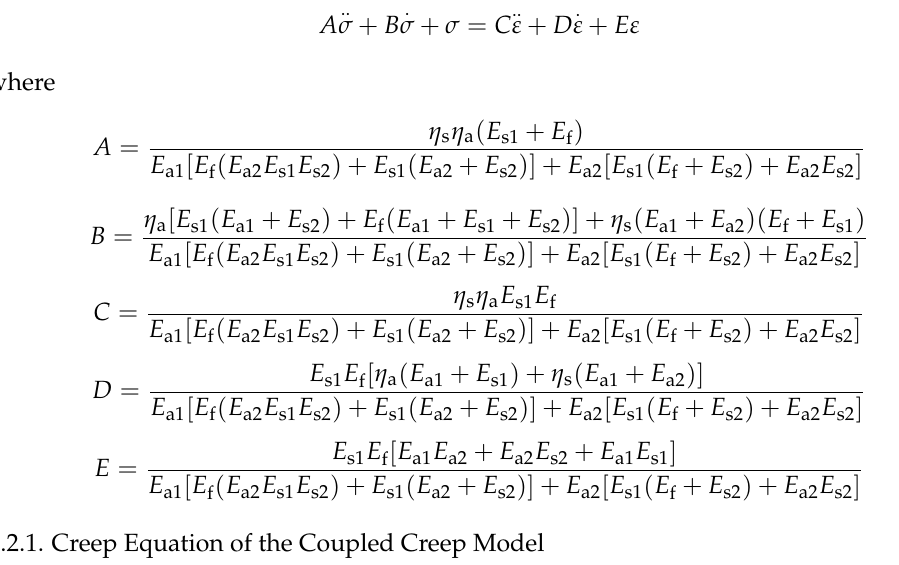
Figure 5. The anchor cable – rock and soil coupled creep model. According to the coupled creep model of the anchor cable and the rock and soil mass